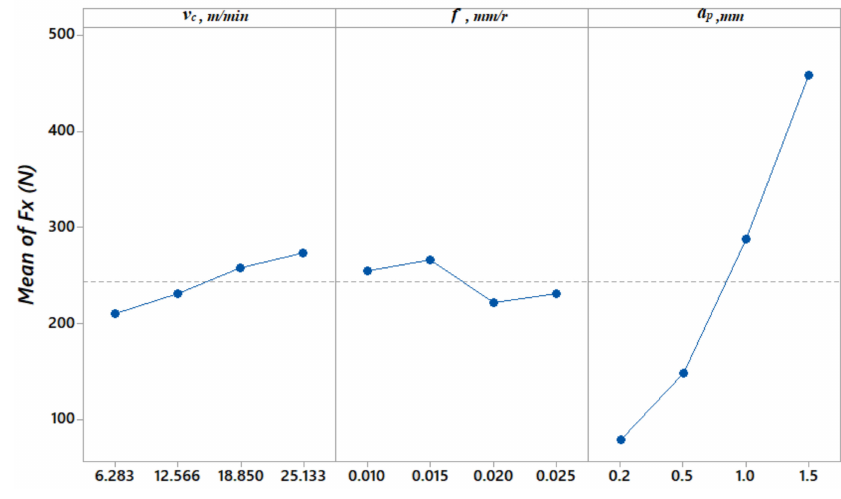
Figure 2. Main e ff ect plots for F x cutting force.